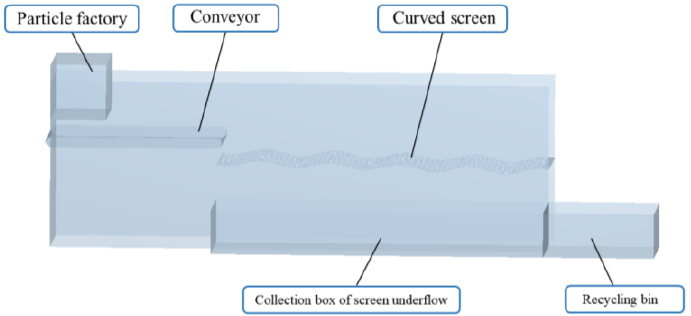
Figure 7. Discrete element model of vibrating screen.